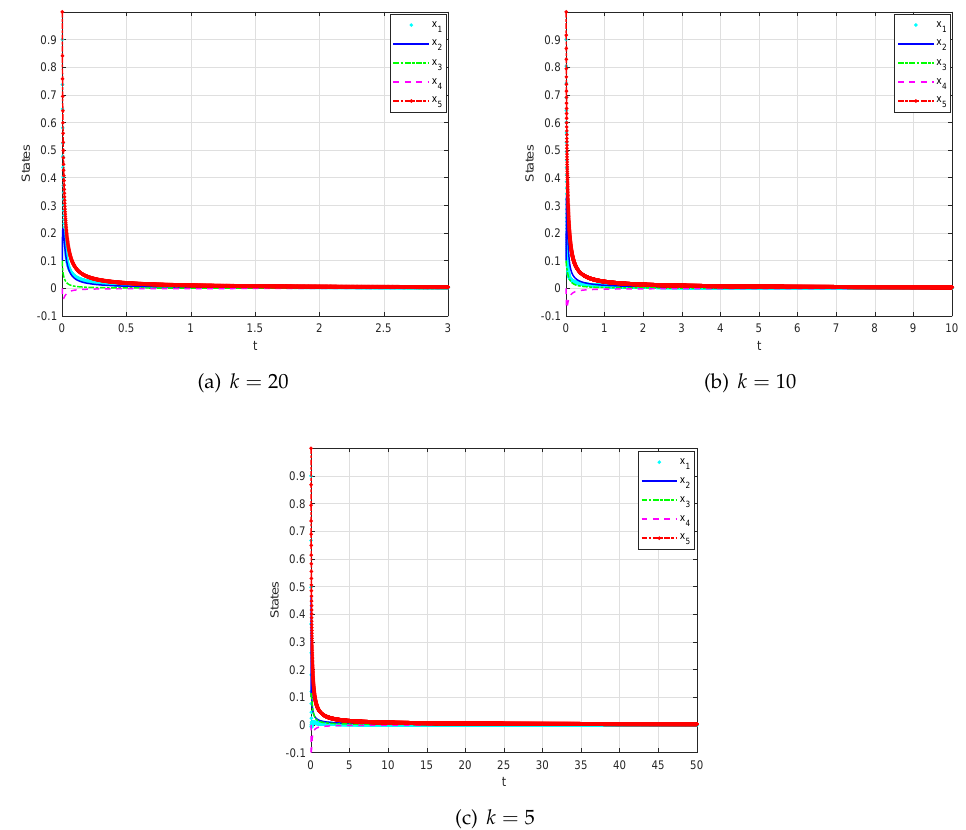
= 0.7, k = 20,10, and